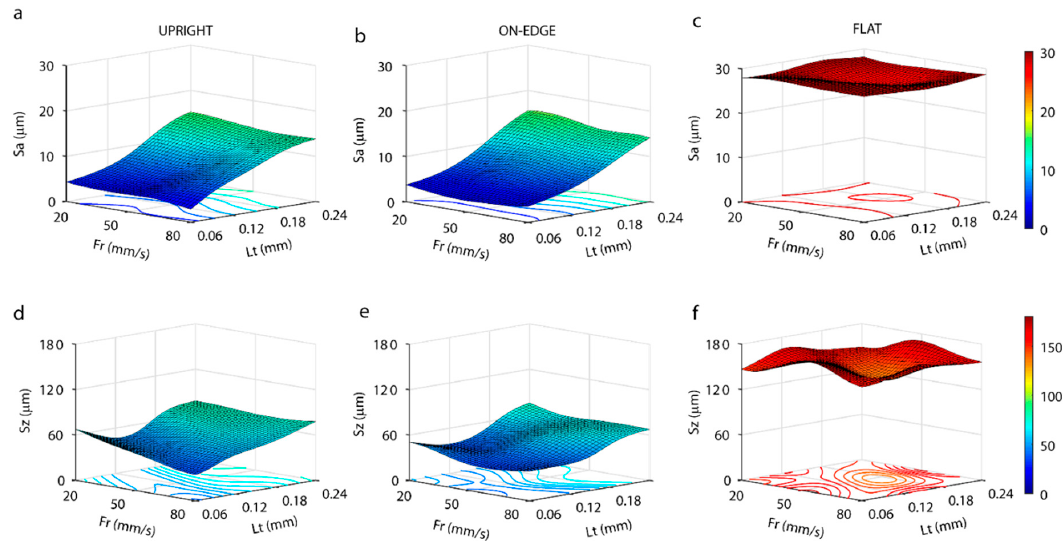
Figure 12. Response surface obtained by artificial neural networks for roughness: Sa parameter ( a–c ), and Sz parameter ( d–f ).